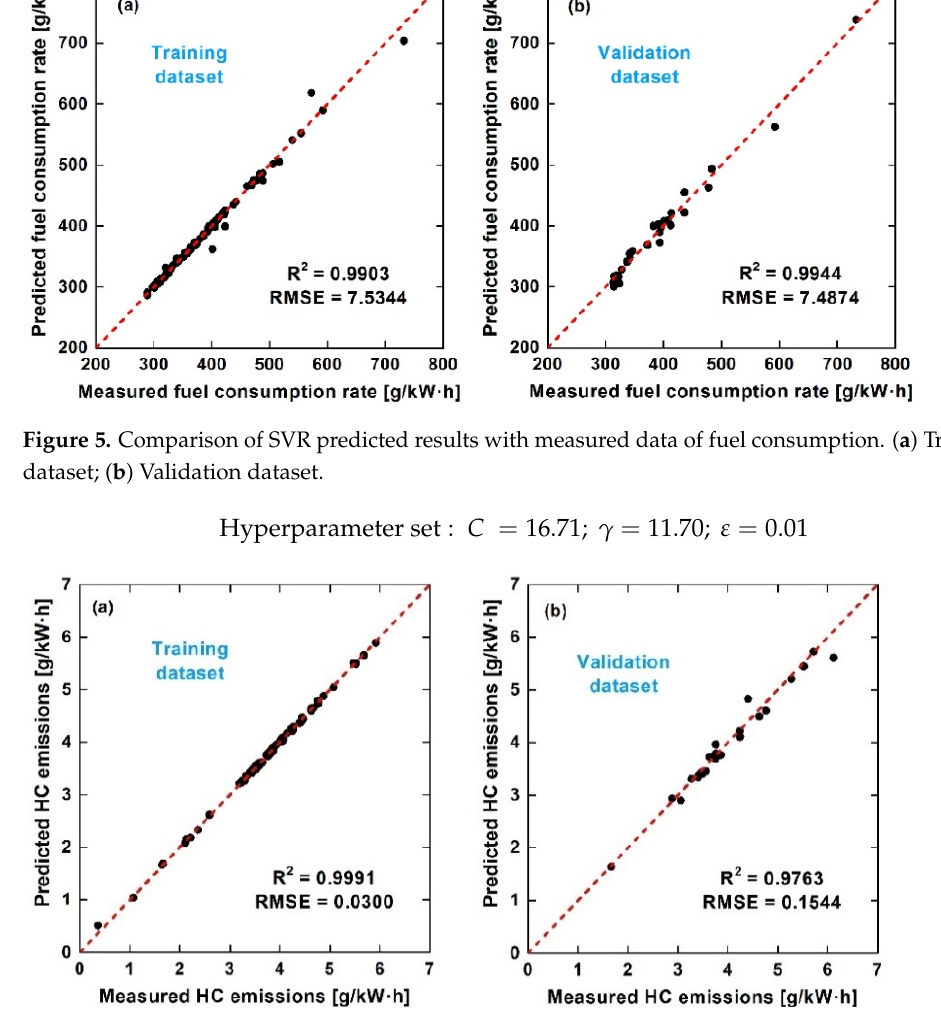
Figure 7. Comparison of SVR predicted results with measured data of CO emissions. ( a ) Training dataset; ( b ) Validation dataset. Hyperparameter set: C = 99.74; γ = 3.58; 𝜀 = 0.01 Figure 8. Comparison of SVR predicted results with measured data of NO x emissions. ( a ) Training dataset; ( b ) Validation dataset. The R 2 and RMSE of the fuel consumption for the training dataset were 0.9903, 7.5344, and for the validation dataset, these values were 0.9944 and 7.4874. The R 2 and RMSE of